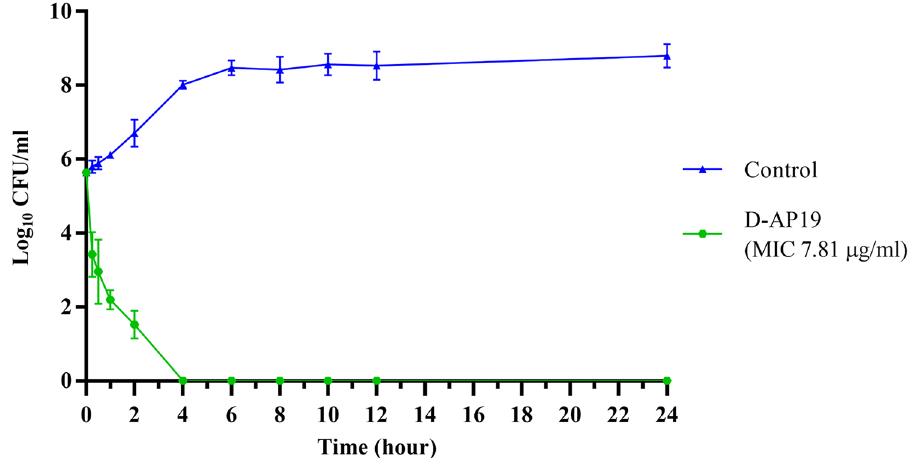
Figure 4. Time-kill kinetics of D-AP19 at 1 × MIC against A. baumannii ATCC 19,606 for 24 h. Control (blue line) indicates untreated bacteria grown in MHB-DI solution. Green line indicates A. baumannii ATCC 19,606 treated with D-AP19 at 1 ×